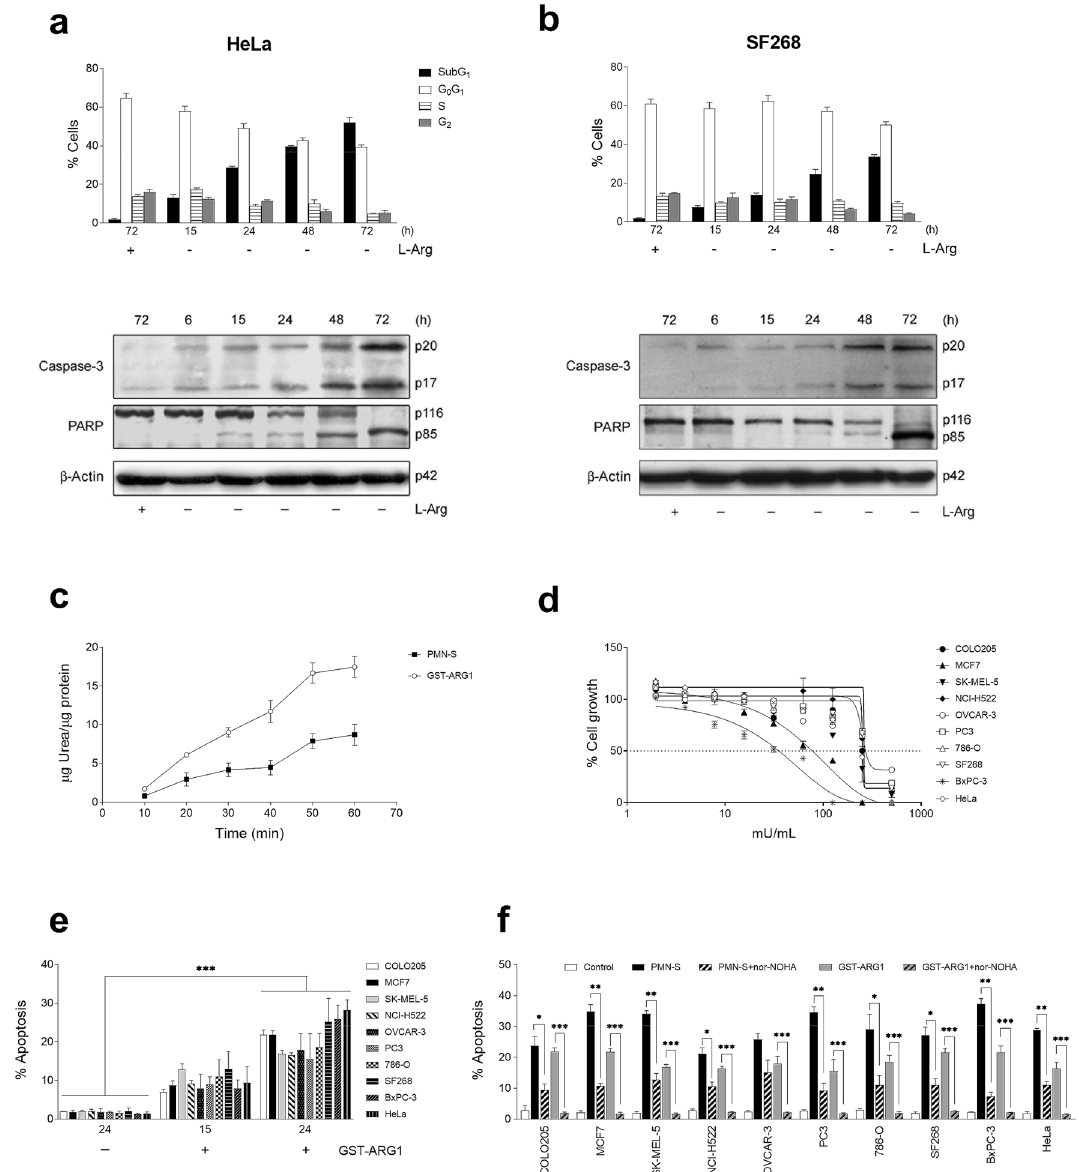
Figure 1. Induction of apoptosis in cancer cells grown in arginine-free culture medium and following arginine depletion by neutrophil arginase. HeLa ( a ) and SF268 ( b ) were cultured in RPMI 1640 medium with (+) and without (−) L-Arg. At the indicated times, the cell cycle was evaluated by flow cytometry. Caspase-3 activation and PARP-1 (PARP) cleavage were evaluated by Western blot. Molecular weights (in kilodaltons) of each protein are indicated at the right side of each panel. β-Actin was used as loading control. ( c ) Arginase activity of the recombinant neutrophil protein GST-ARG1 and neutrophil sonicate (PMN-S). Urea generation (μg urea produced/μg protein) was quantified every 10 min up to a total of 60 min. ( d ) A dose–response curve for the GST-ARG1 effect on cell proliferation of the indicated cell lines for 72 h was determined using the XTT assay. ( e ) Induction of apoptosis in the indicated cell lines following incubation in the absence or presence of 300 mU/ ml GST-ARG1 for 15 and 24 h. ( f ) Induction of apoptosis in the indicated cell lines following incubation with 300 mU/ml of PMN-S or GST-ARG1 for 24 h in the presence or absence of the nor-NOHA arginase inhibitor (50 μM). The percentage of apoptotic cells was determined by flow cytometry ( e , f ). The gels were cropped to show the relevant sections. The data are representative of three independent experiments or shown as mean ± SD of three independent experiments. Asterisks indicate significant differences. * P ˂ 0.05; ** P ˂ 0.01; *** P ˂ 0.001. (GraphPad Prism 8.0.1—proprietary commercial software—https:// www. graph pad.